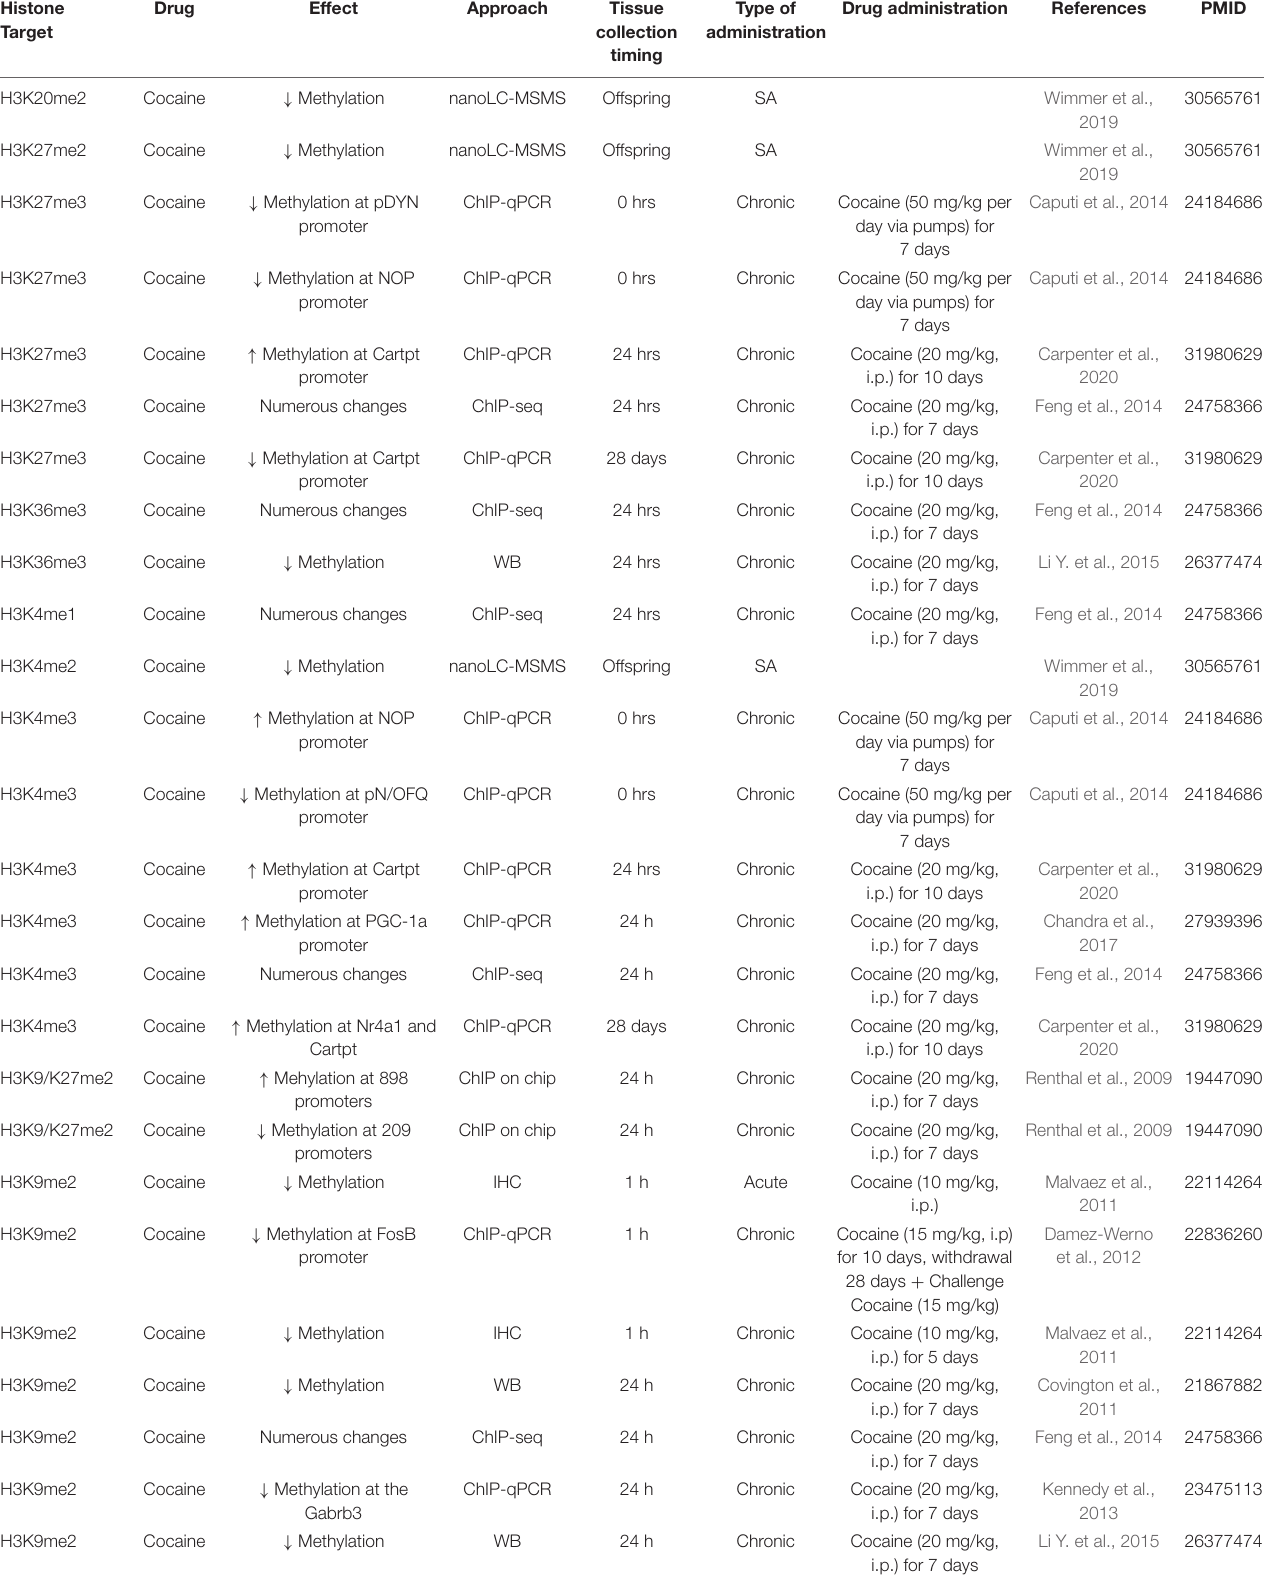
TABLE 2 | Effects of drug exposure on histone